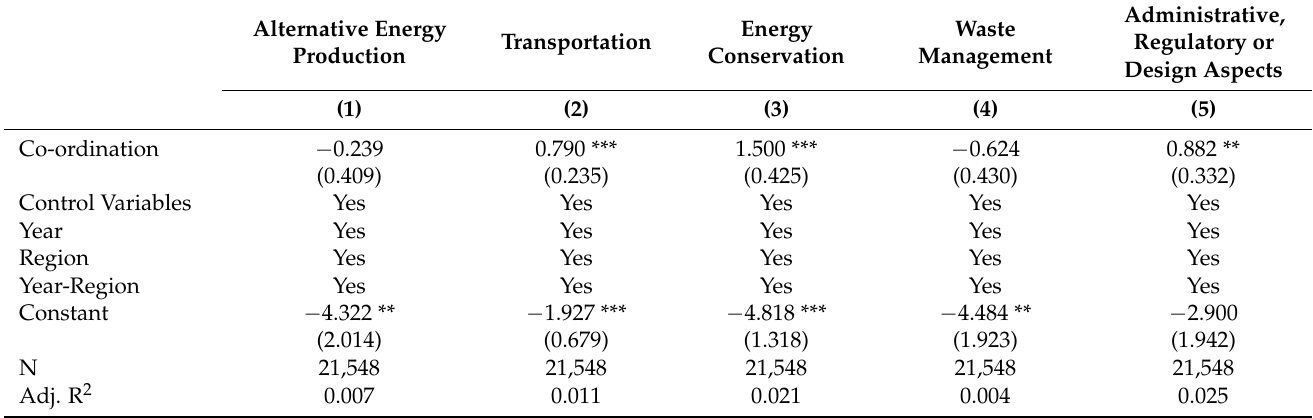
Table 9. Heterogeneity test of green technology category.